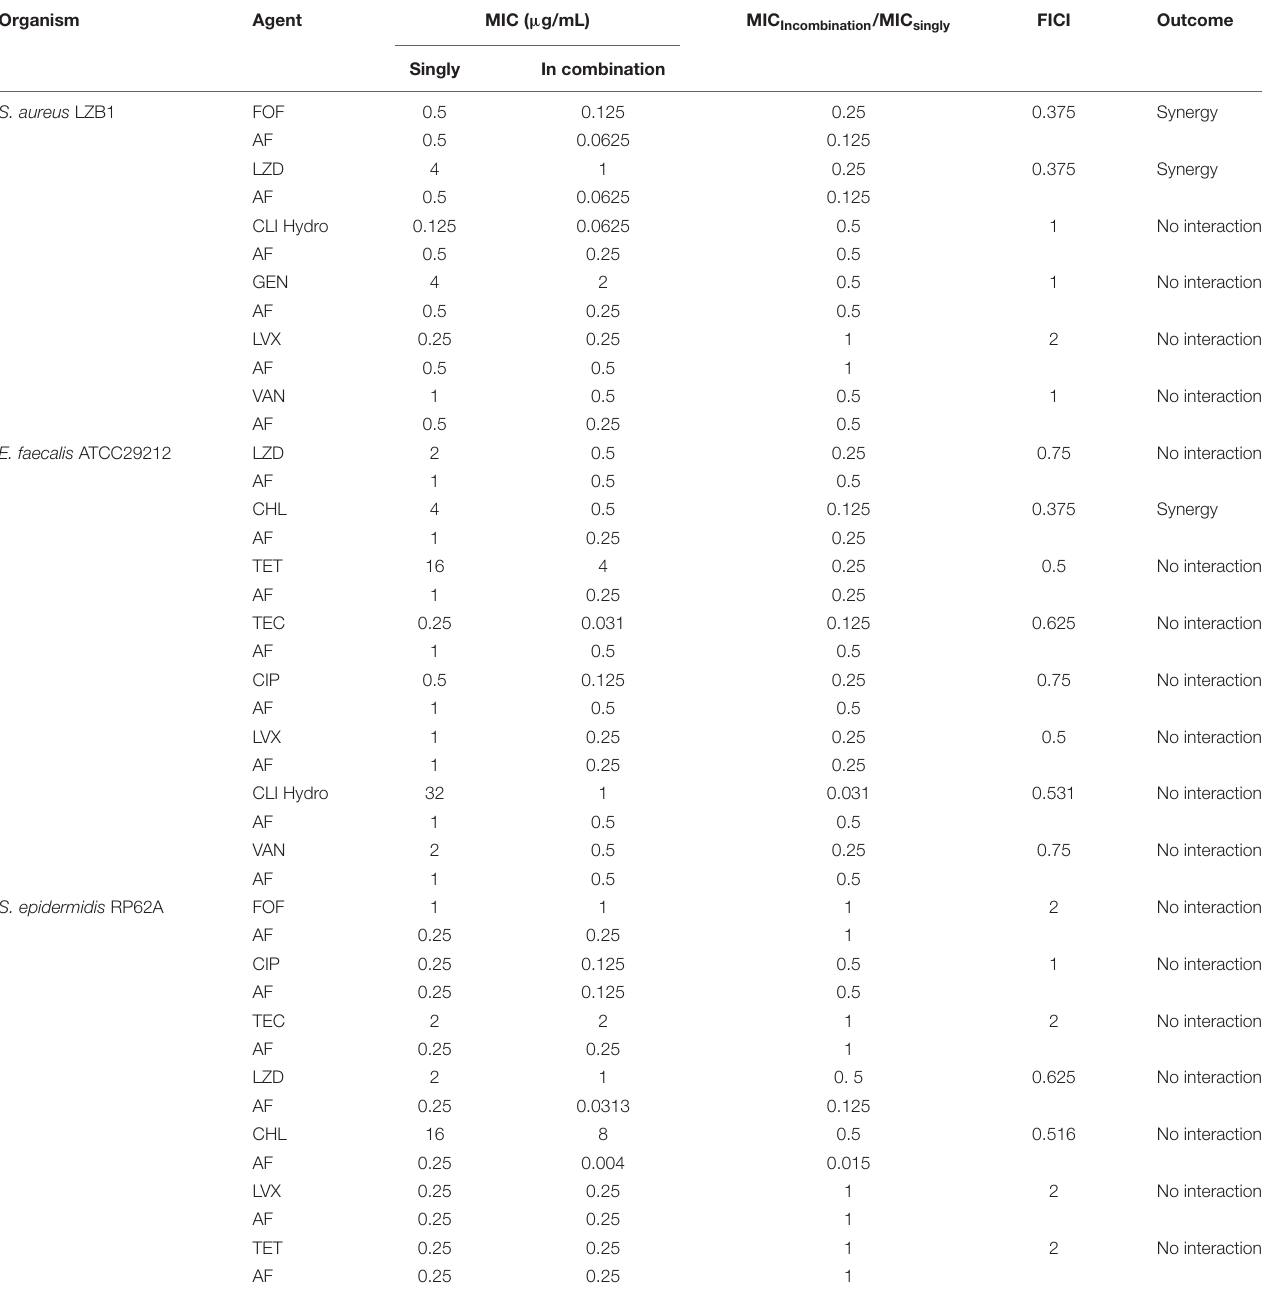
TABLE 2 | The combinational antibacterial activities of AF and different antibiotics. Organism